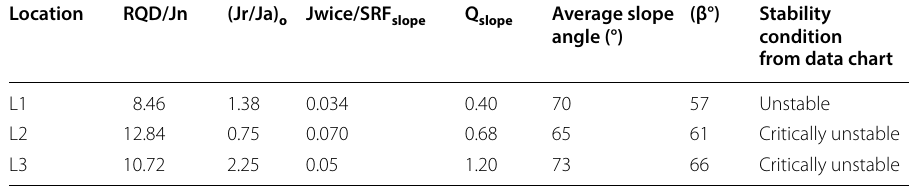
Table 6 Estimated Q Location